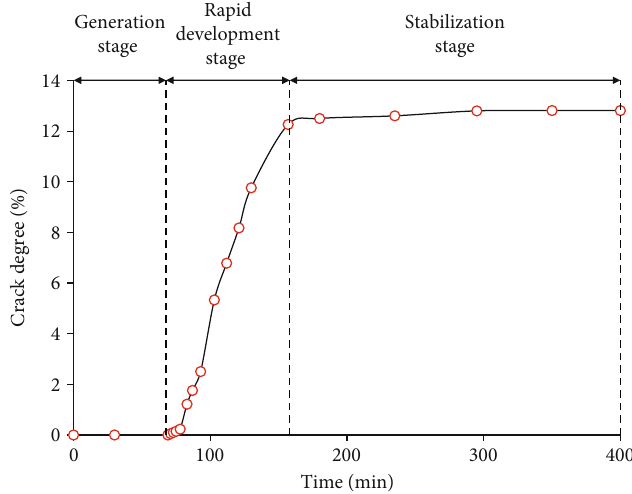
Figure 6: Curve of crack degree over time of 2#